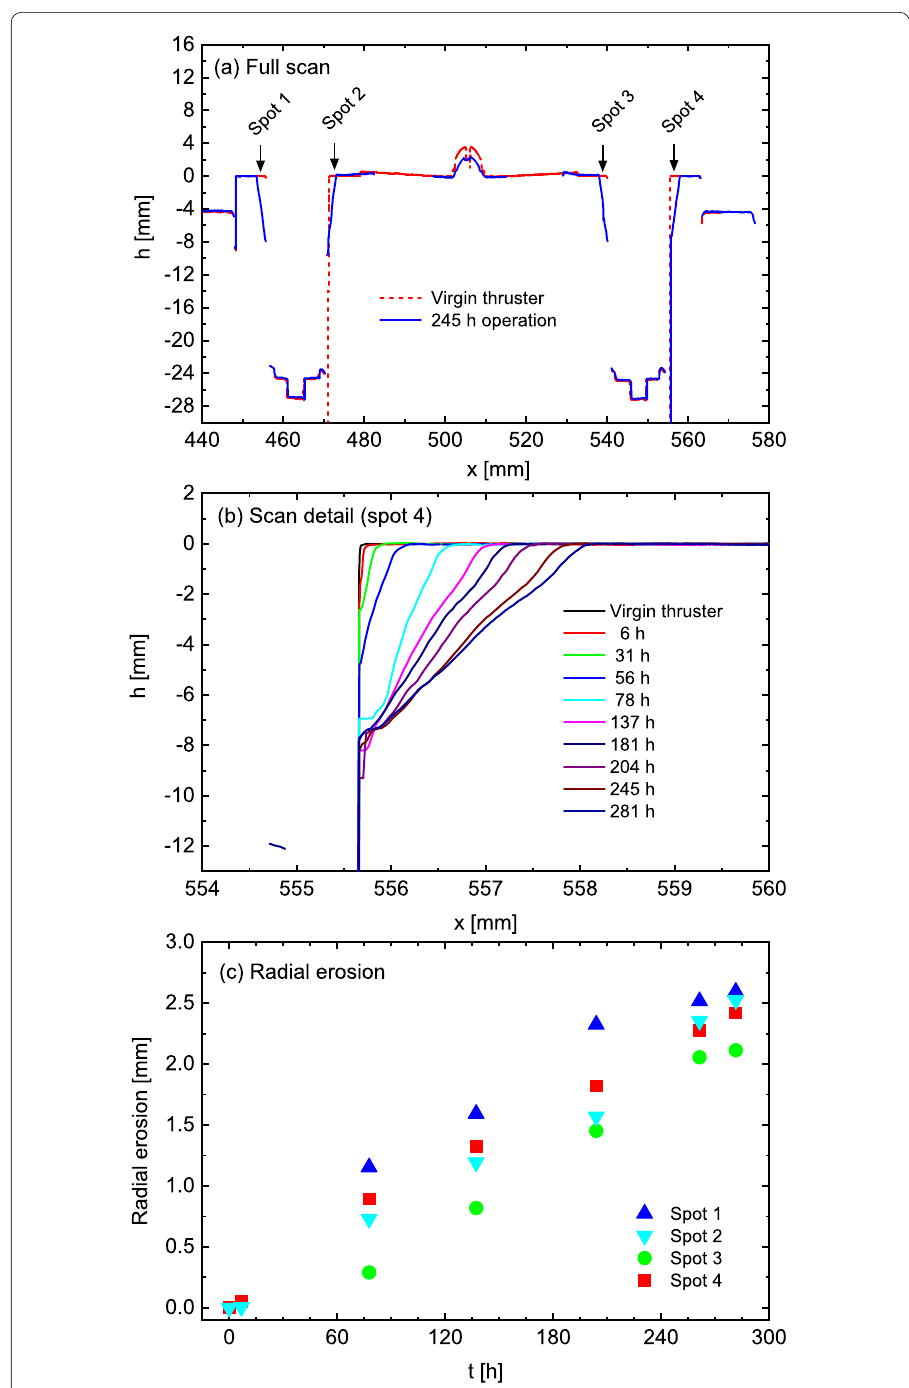
Figure 15 Horizontal TLH linescans across the center of the SPT-100D: full line scans at two operation times ( a ), scan detail of measurement spot 4 for several operation times ( b ), and extracted radial erosion data versus operation time ( c